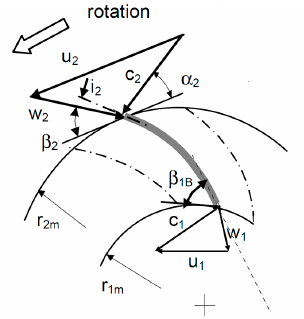
Figure 2. Velocity triangles in turbine